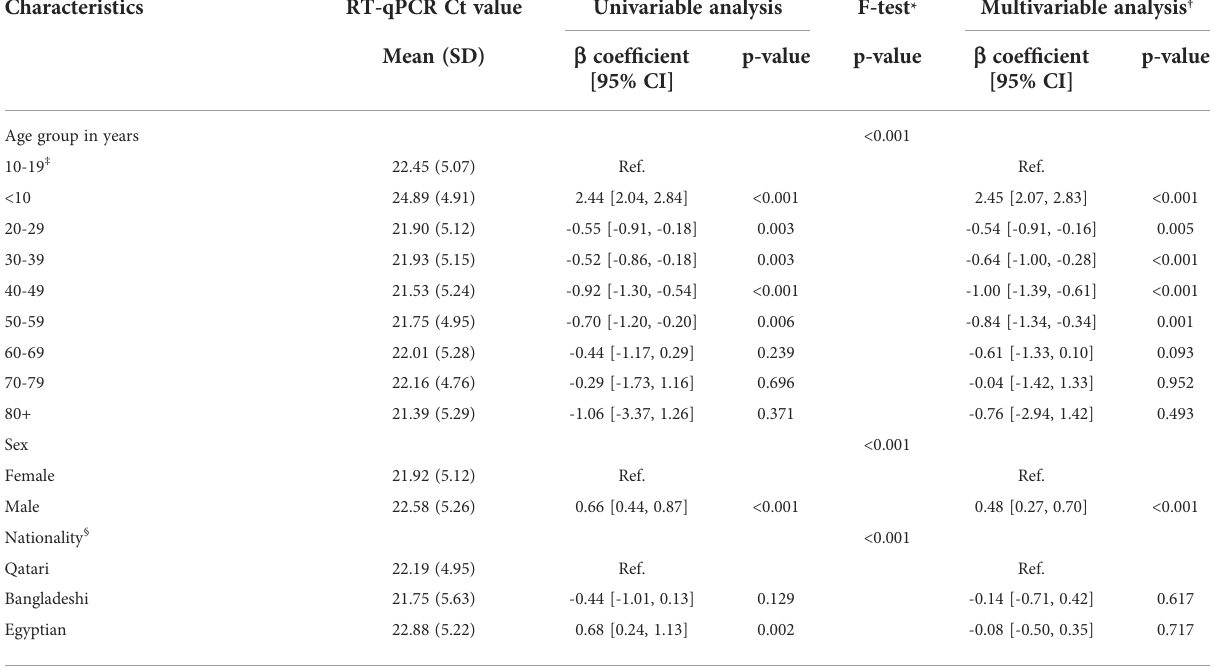
TABLE 5 Associations with RT-qPCR Ct value among 9,432 Delta RT-qPCR-genotyped SARS-CoV-2 infections between March 23 and November 6, 2021.